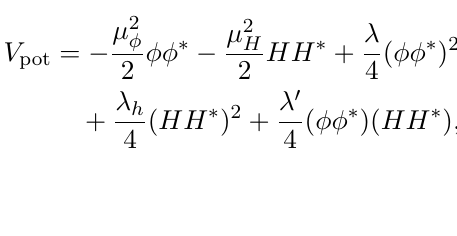
JHEP03(2023)164